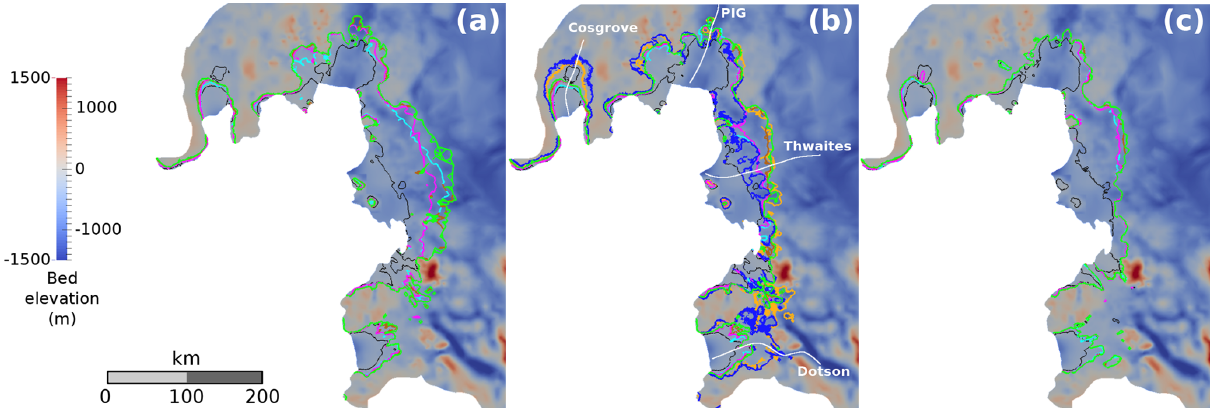
Figure 8. Bed elevation (m) and GL positions at the end of the experiment EXP_ABMB for the inferred states, (a) I R (c) I R , and the friction laws, linear Weertman (cyan), non-linear Weertman (magenta), Schoof with C max = 0 . 4 (green), Schoof with γ, 1 C max = 0 . 6 (brown), linear Budd (orange, for the inferred state I R The GL position at t = 0a is reported for each of the three inferred states (solid black lines). The solid white lines in (b) correspond to flow lines at which ice-sheet profiles are represented in Fig.